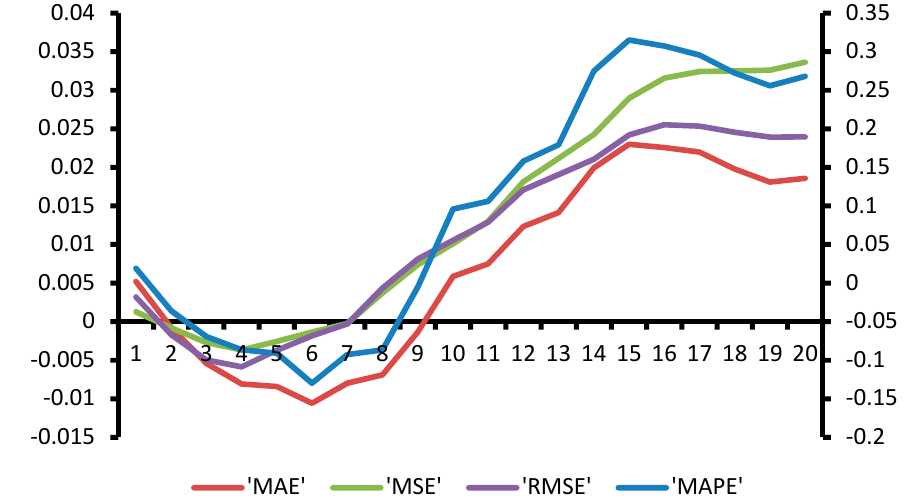
Figure 4. Differential errors between predictions when using only prices of CO 2 emission allowances and when iron and steel prices are added.